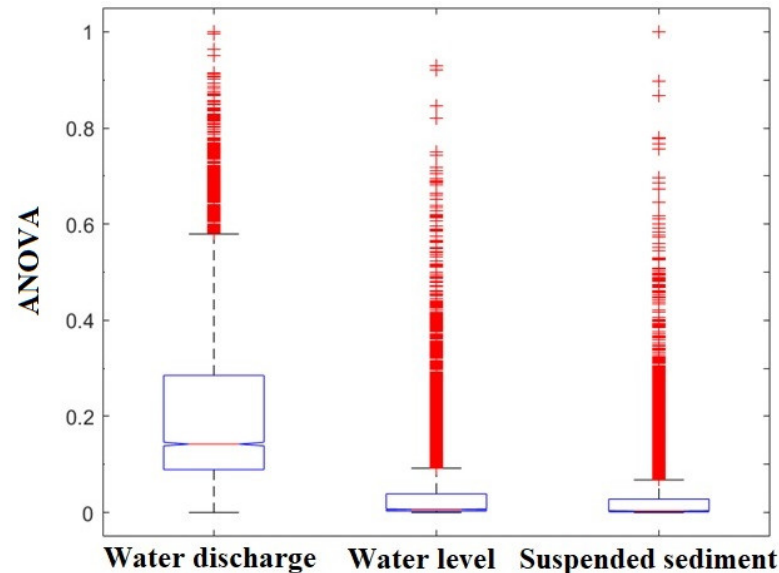
Figure 4. Analysis of variance test result of WD, WL and SSY.